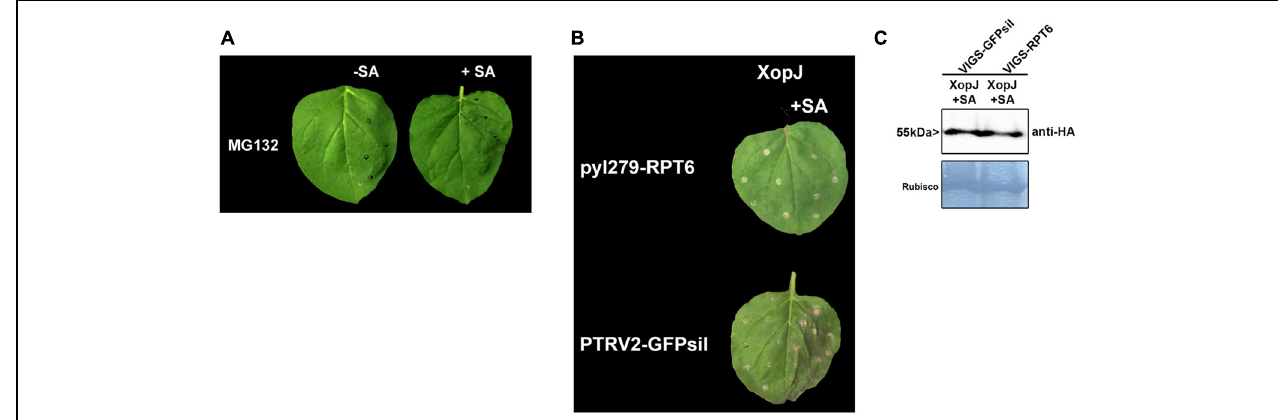
FIGURE 3 | RPT6 is required for XopJ-induced HR-like symptoms. (A) Phenotypes of N. benthamiana leaves infiltrated with 100 μ M MG132 with or without SA. (B) XopJ was transiently expressed in RPT6 silenced leaves or control plants and treated with 5 mM SA 24 hpi. Plant reactions were